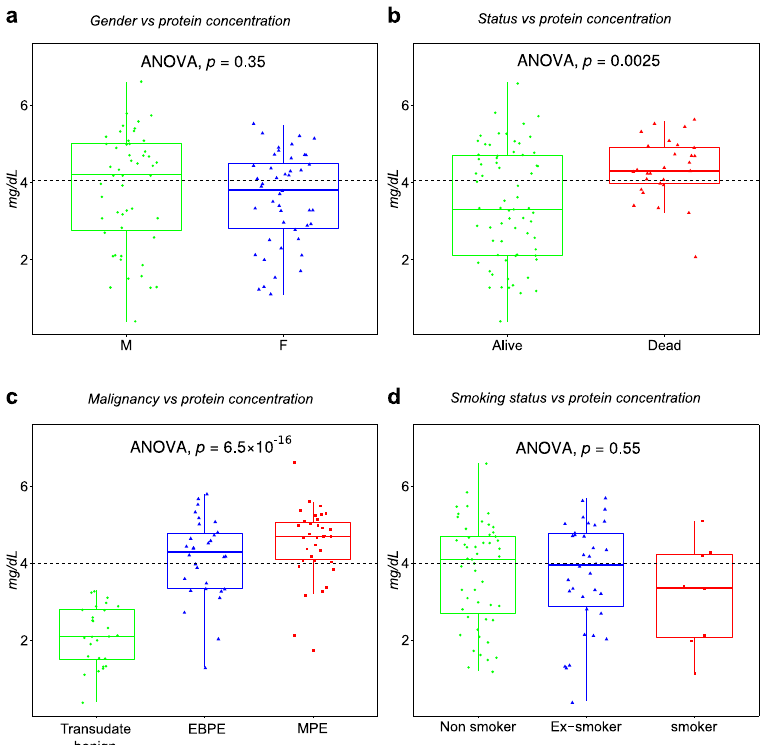
Figure 1. Boxplot of total protein concentration as function ( a ) gender, ( b ) survival status, ( c ) malig- nant status and ( d ) smoking status.